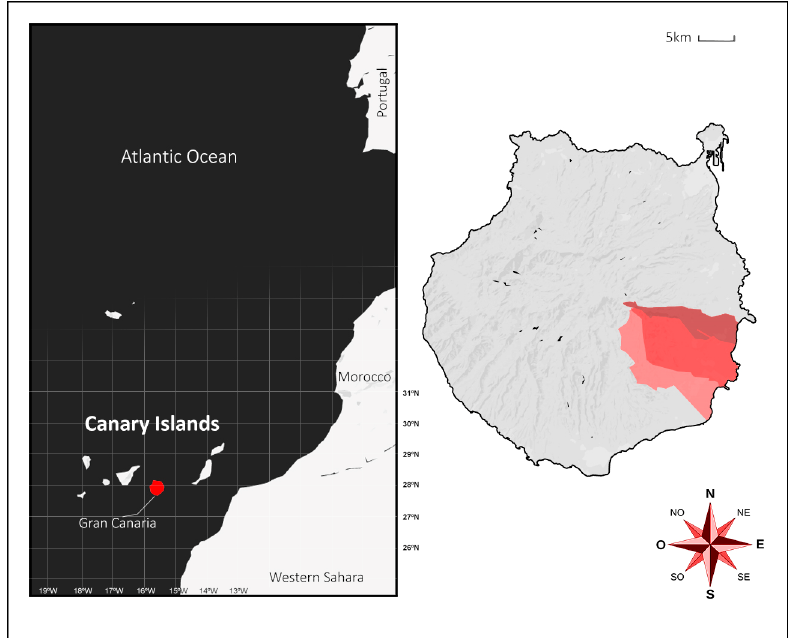
Figure 1. Location of the study area in the Canary Islands (Spain) (Southeast Region of the Gran Canaria Island in red shades). Source: Own elaboration.